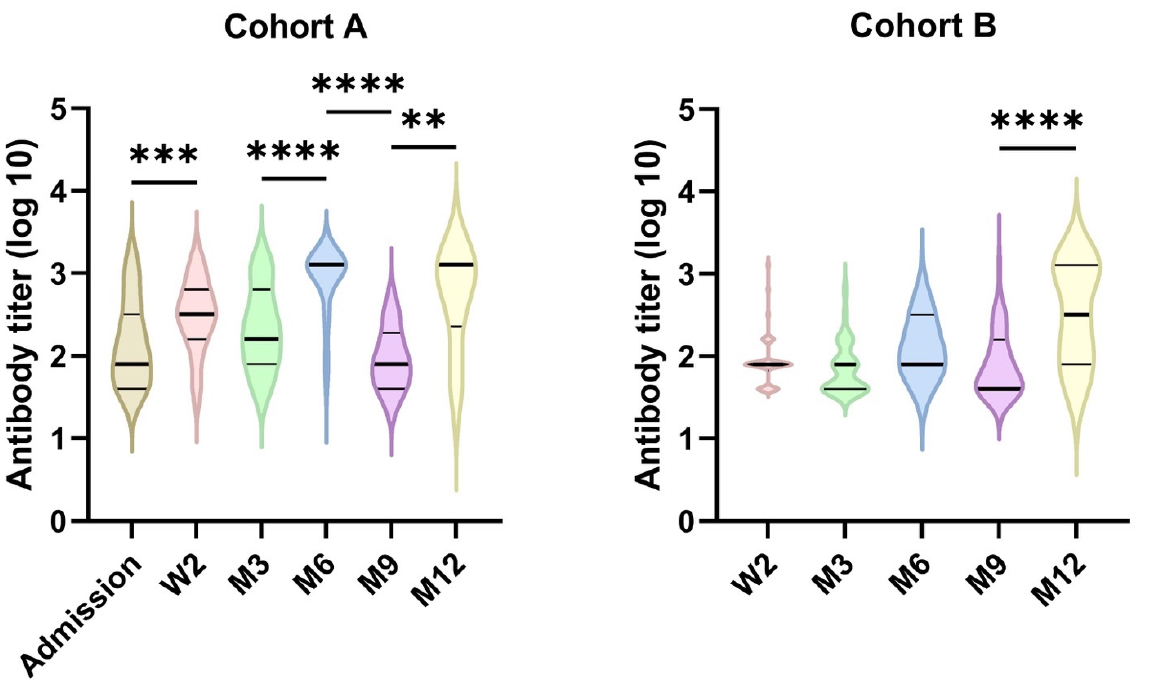
Figure 4. The dynamics of virus neutralization titers in time. The graph illustrates the higher titers in the patients from cohort A in general, and increases in the titers between months 9 and 12 in both cohorts due to vaccination. The statistical evaluation was performed using the nonparametric Mann–Whitney test with the significance set at p < 0.05. **** denotes the statistical significance at p < 0.0001, *** at p = 0.0002 and ** at p = 0.0036. Because of the increasing numbers of samples from vaccinated patients at 6, 9 and 12 months, the overall VNT levels increased and the 1:160 and higher titers were found in 88.68 to 78.58% of the samples in cohort A and 33.33 to 50.91% in cohort B (see